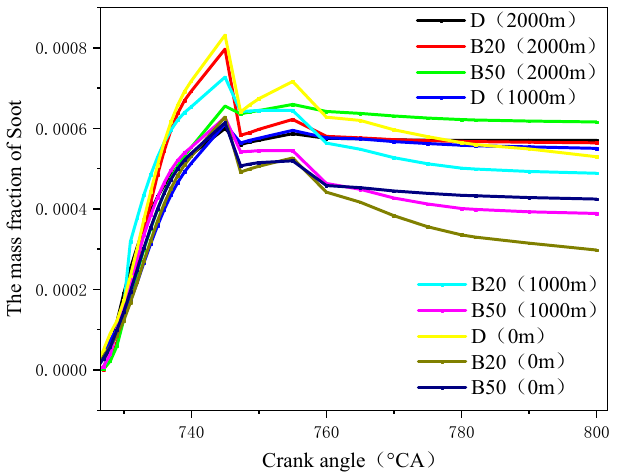
Figure 8. Effect of different plateau environments on soot emissions of diesel with different blending ratios.